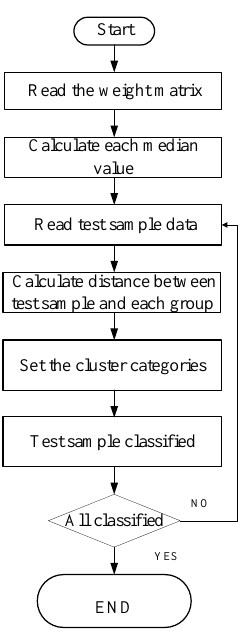
Figure 4. ENN flow chart. 209